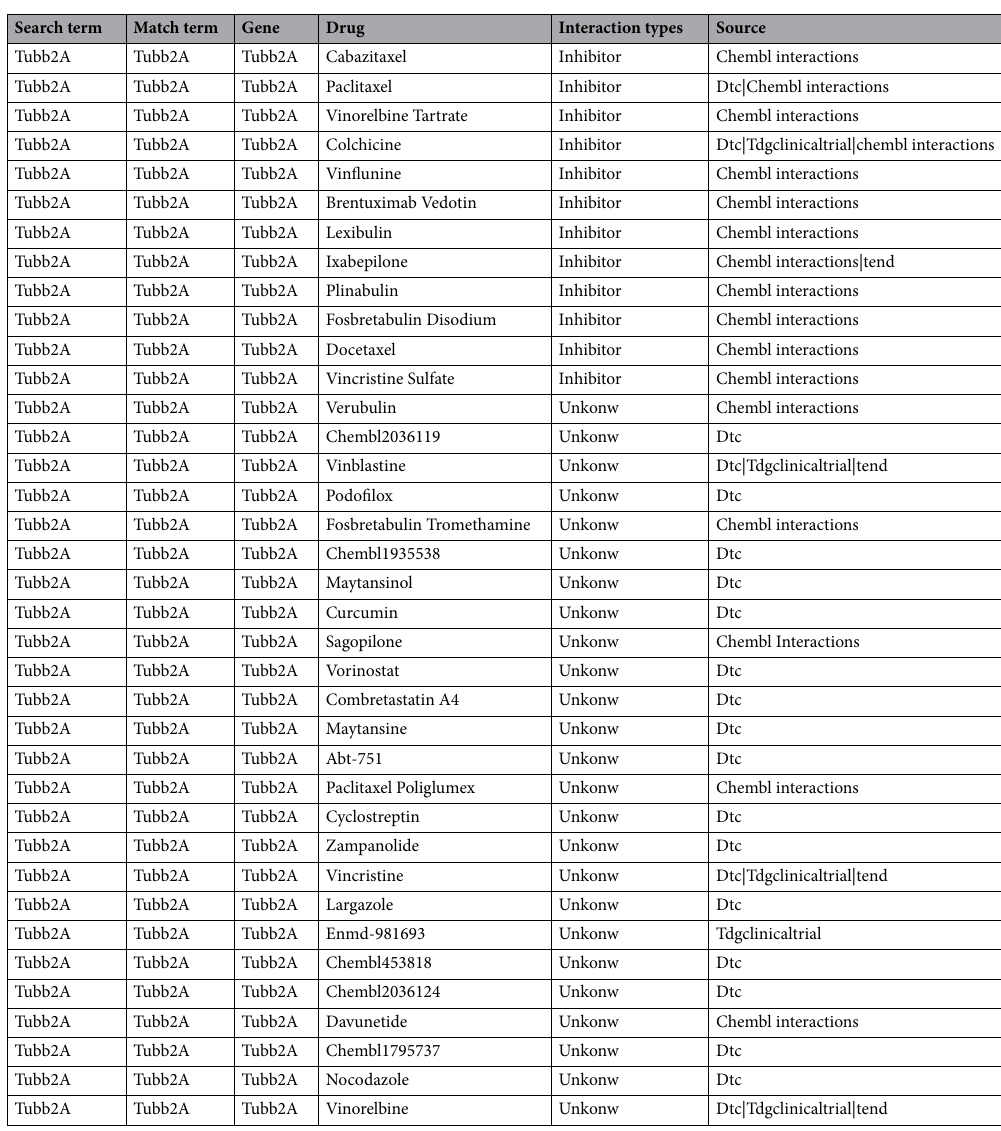
Table 2. Drug-gene interactions of all